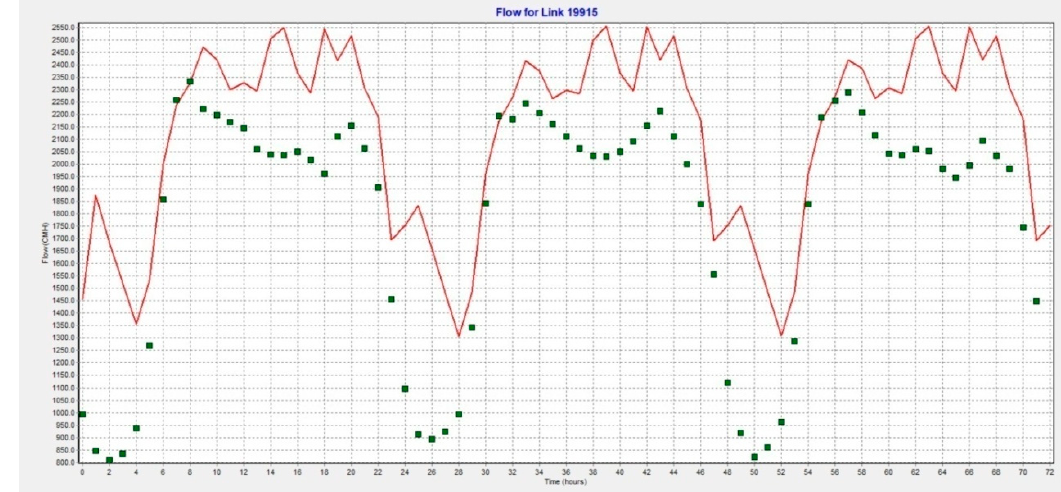
Figure 11. Results of Scenario III for Tanks E, west direction.